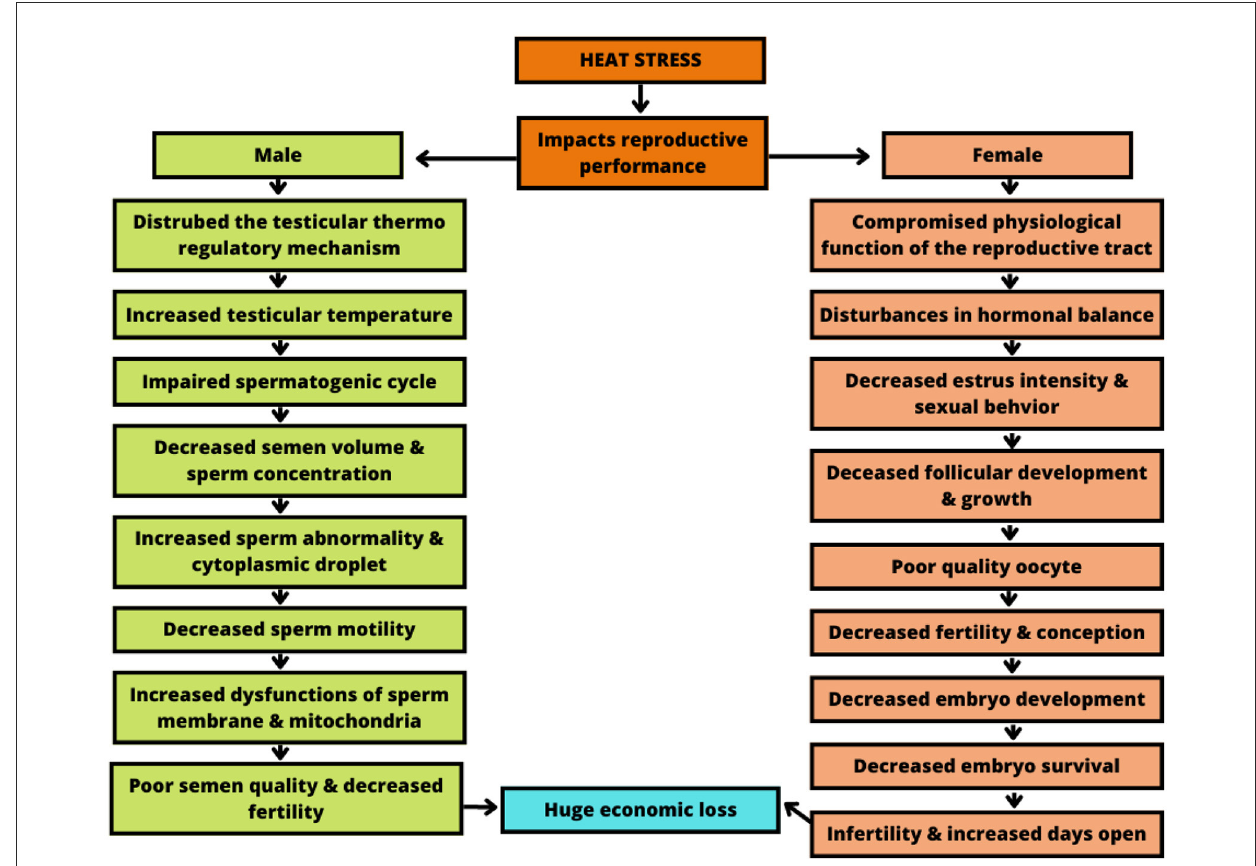
FIGURE5 Impact of heat stress on pregnancy in livestock. Adapted from Krishnan et al. (37). Mitigation of the heat stress impact in livestock reproduction.